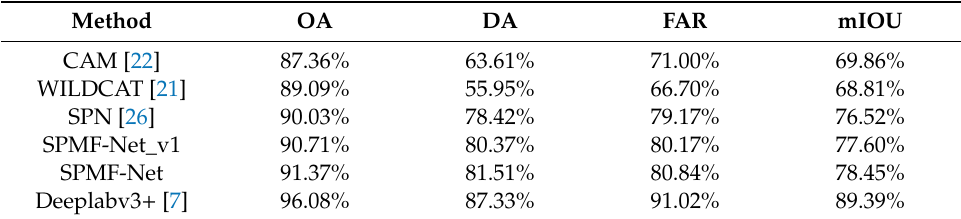
Table 1. Comparison of quantitative results on the Potsdam dataset.